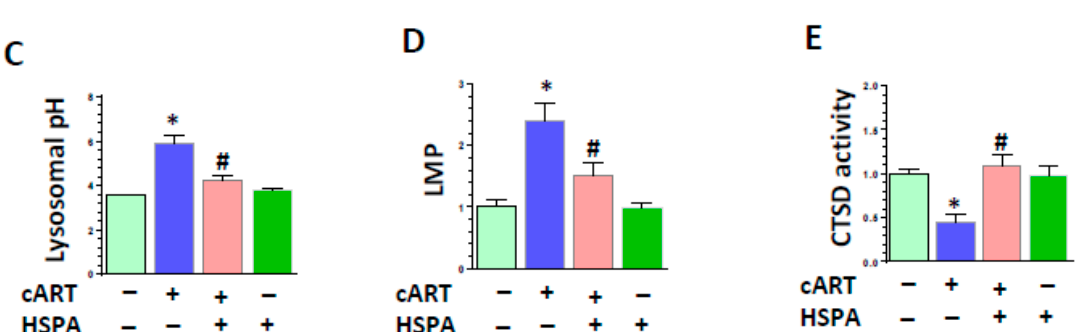
Figure 5. HSPA overexpression abrogated cART-mediated impairment of lysosomal function. Control rPMs and heat shock protein family A (HSPA) overexpressing rPMs were seeded into six-well plates subjected to various treatments for 24 h. Protein homogenates were prepared for the detection of the indicated molecules. ( A , B ) Representative western blots showing overexpressing HSPA in rPMs reversed cART-mediated downregulation of LAMP2 and mCTSD expression levels. ( C ) Representative bar graph showing overexpression of HSPA in rPMs protected lysosomal pH. ( D , E ) Representative bar graphs showing HSPA protected LMP ( D ), and CTSD activity ( E ) in cART-treated rPMs. For all western blots, ACTB served as a protein loading control. Data is from three independent experiments and is expressed as means ± SEM and were analyzed using student t-test or one-way ANOVA. *, p < 0.05 vs. control; # , p < 0.05 vs. cART.